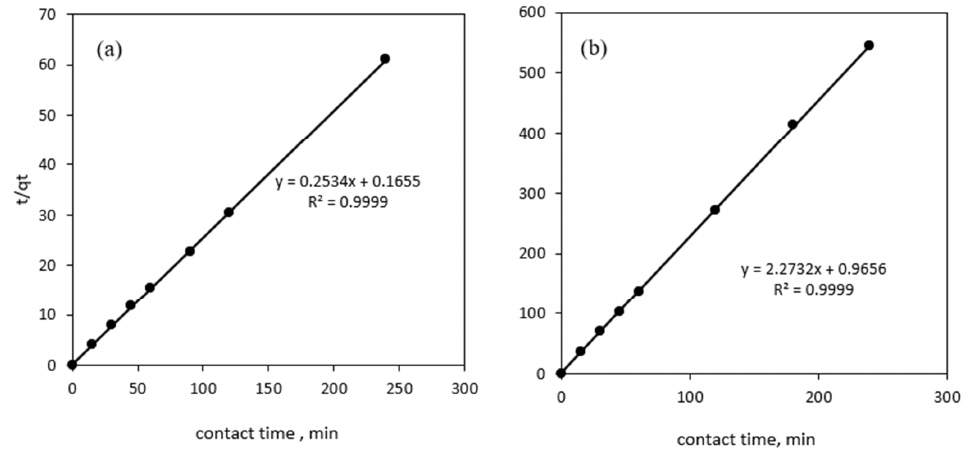
Figure 10. Plot of ( a ) Pseudo second ‐ order kinetic plot on SA ‐β‐ CD hydrogel ( b ) Pseudo second ‐ order kinetic plot on SA ‐β‐ CD/CNTs hydrogel of Ni(II) adsorption .